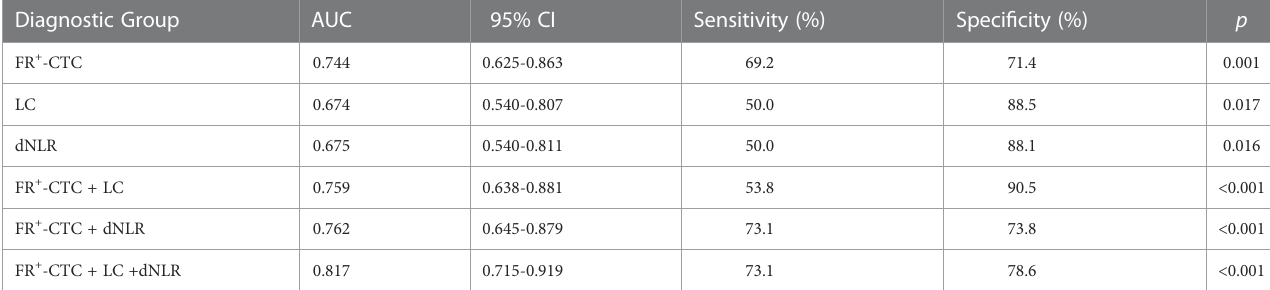
TABLE 5 The diagnostic ef fi ciency of models in patients with lung cancer. Diagnostic